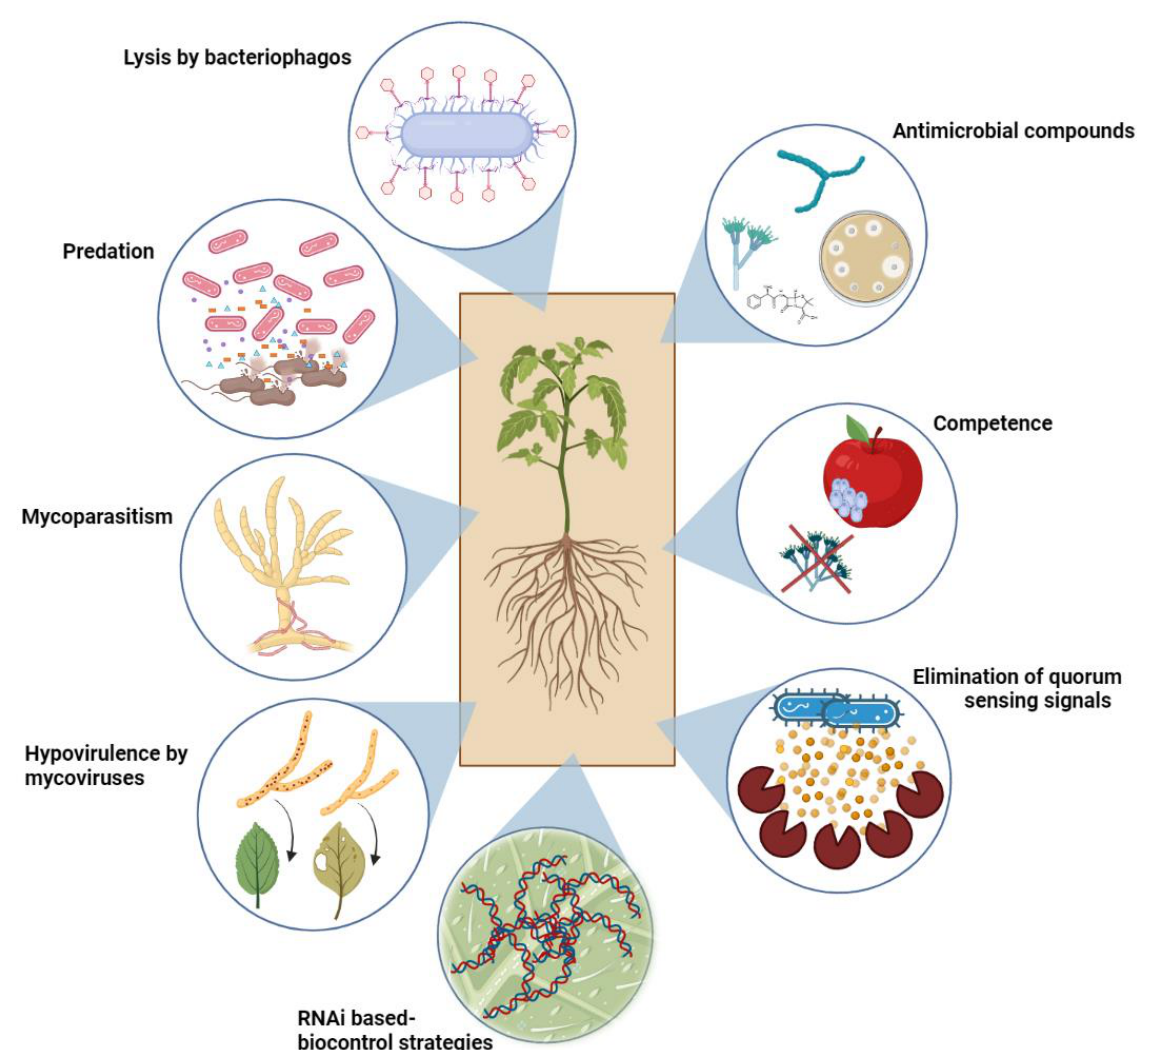
Figure 1. Different modes of action of biocontrol agents to inhibit plant pathogens. Mechanisms involving physical contact are on the left of the figure, and those in which physical contact is not a prerequisite are on the right. Created with Biorender (https://biorender.com/, accessed on 9 February 2023).